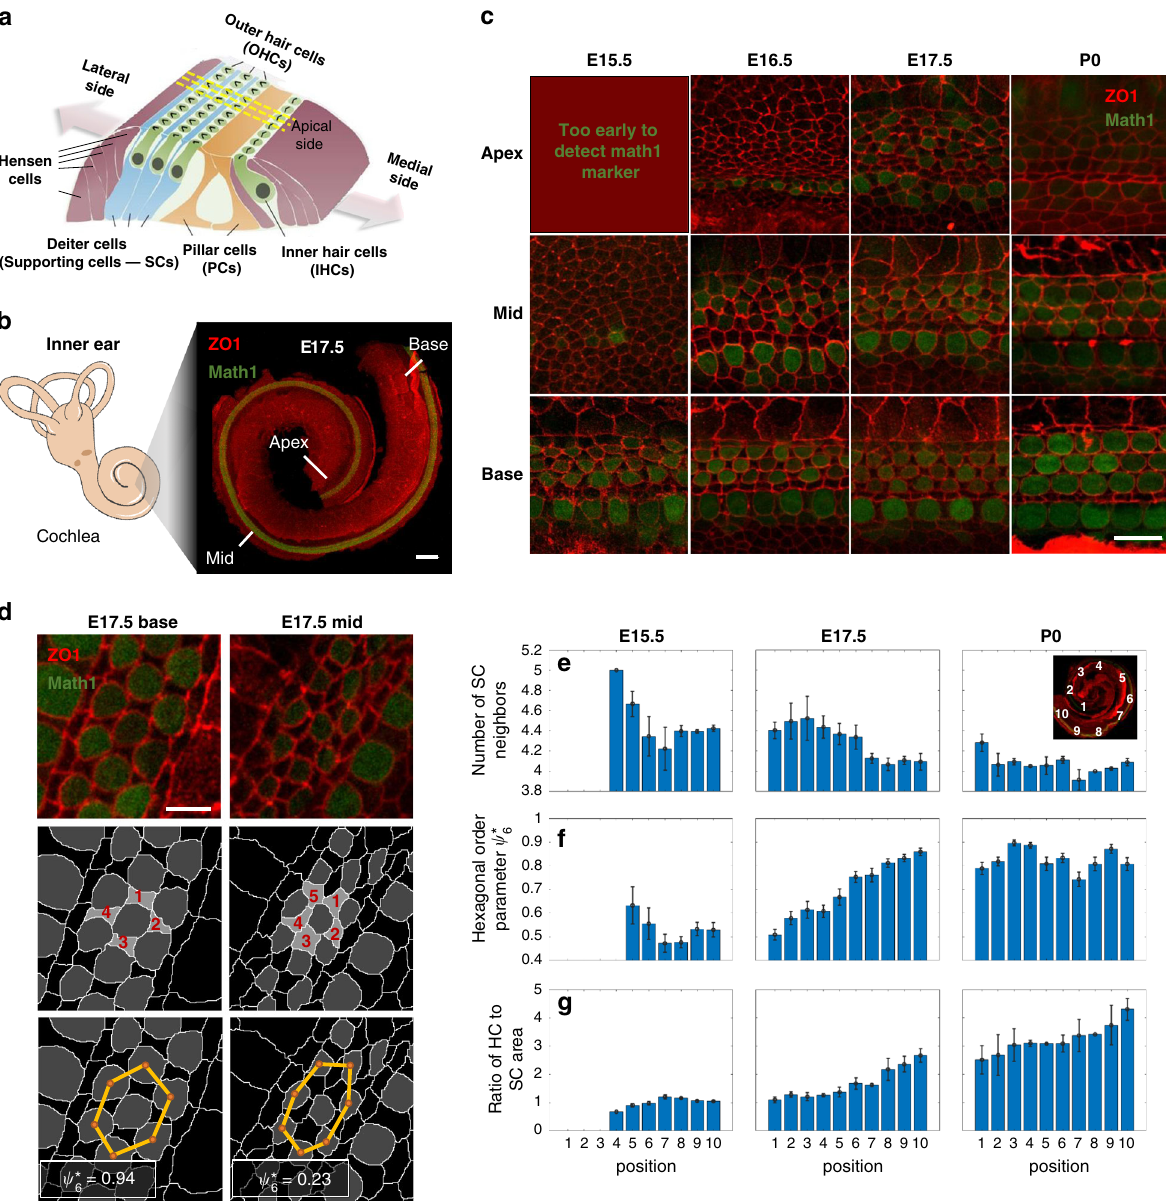
Fig. 1 Hair cells gradually reorganize into a checkerboard-like pattern. a Schematic of the organ of Corti. b Left: schematic of the mammalian inner ear. Right: Confocal image of the cochlea of a E17.5 mouse embryo marking the base, mid and apex regions. Cochleae are taken from transgenic mice expressing Math1-GFP (green) and are immunostained with α -ZO1 (red). Scale bar: 100 μ m. c Representative images at different developmental times and different positions along the base-to-apex axis. Rows and columns correspond to different positions along the cochlear axis and different development times, respectively, as indicated. Scale bar: 10 μ m. d Schematic of the de fi nition of two order parameters: (i) The number of SC neighbors of each HC in OHC 2 (middle row) and (ii) hexagonal order parameter ψ (cid:1) (bottom row). Yellow lines connecting HC centroids (orange dots) demonstrate higher 6 hexagonal order at the base relative to the mid. ψ (cid:1) values for each centroid cluster are as indicated. Scale bar: 5 μ m. e – g Morphological and order 6 parameters in different regions of the cochlea from apex to base (de fi ned in inset) and at different developmental times (columns). Rows correspond to number of SCs neighbors ( e ), hexagonal order parameter ψ (cid:1) ( f ), and ratio of HC to SC surface area ( g ). Local measures of order parameters associated 6 with each HC are pooled by developmental age over n = 3,4,3 cochleae at E15.5, E17.5, P0, respectively, and then binned by cochlear position. Bars represent average on all local orders parameters within each bin. Error bars represent S.E.M. Schematic in a is modi fi ed with permission from Dror and Avraham 34 developmental stages (E15.5) compared to later developmental A speci fi c type of reorganization observed in our movies, is a stages (E17.5) (Fig. 2f), and inversely correlated with the degree of situation where a cell, which is initially located within the middle tissue organization. The number of delaminations is relatively of the OHC region, is “ squeezed ” laterally (Fig. 2g and small, typically between 0-2 delaminations per fi eld of view per Supplementary Video 7). Such lateral squeezing processes likely 8 h movie. drive the lateral movement of SCs shown in Fig. 2c. Both lateral squeezing and cellular delaminations seem to be restricted to cells